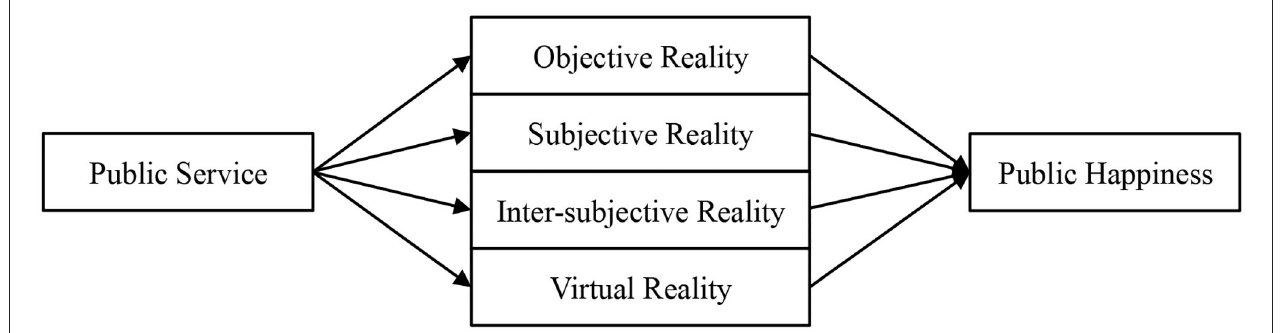
FIGURE 1 | The relationship between public service and public